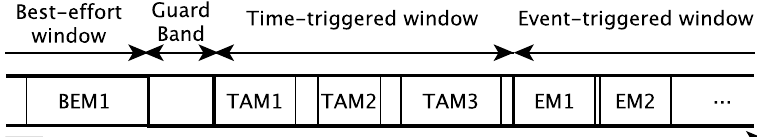
Figure 2. Example of a communication cycle in an output port of a device. The communication cycle is divided into a time-triggered, an event-triggered and a best-effort